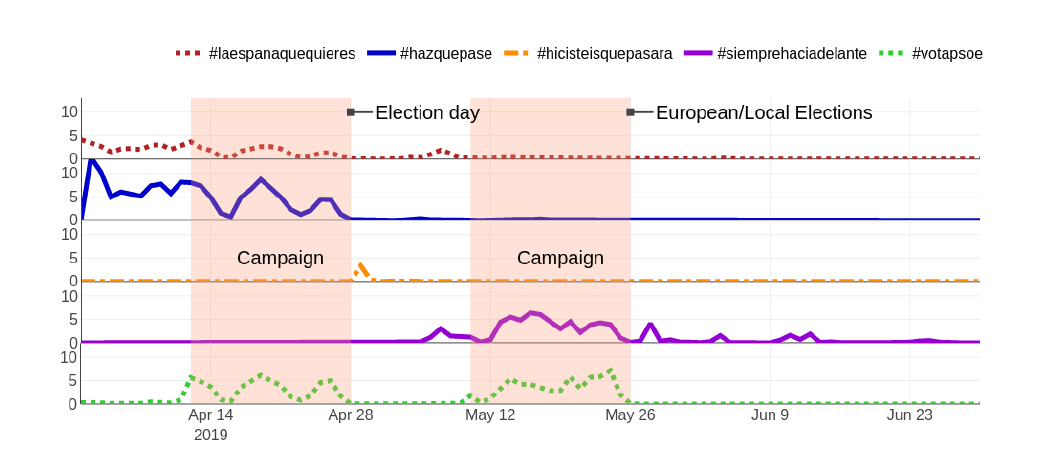
Figure 10. Daily relative amount of tweets extracted using the PSOE-related hashtags in percentage (#laespañaquequieres, #hazquepase, #hicisteisquepasara, #siemprehaciadelante, and #votapsoe). Notice how the activity responds to the electoral processes.